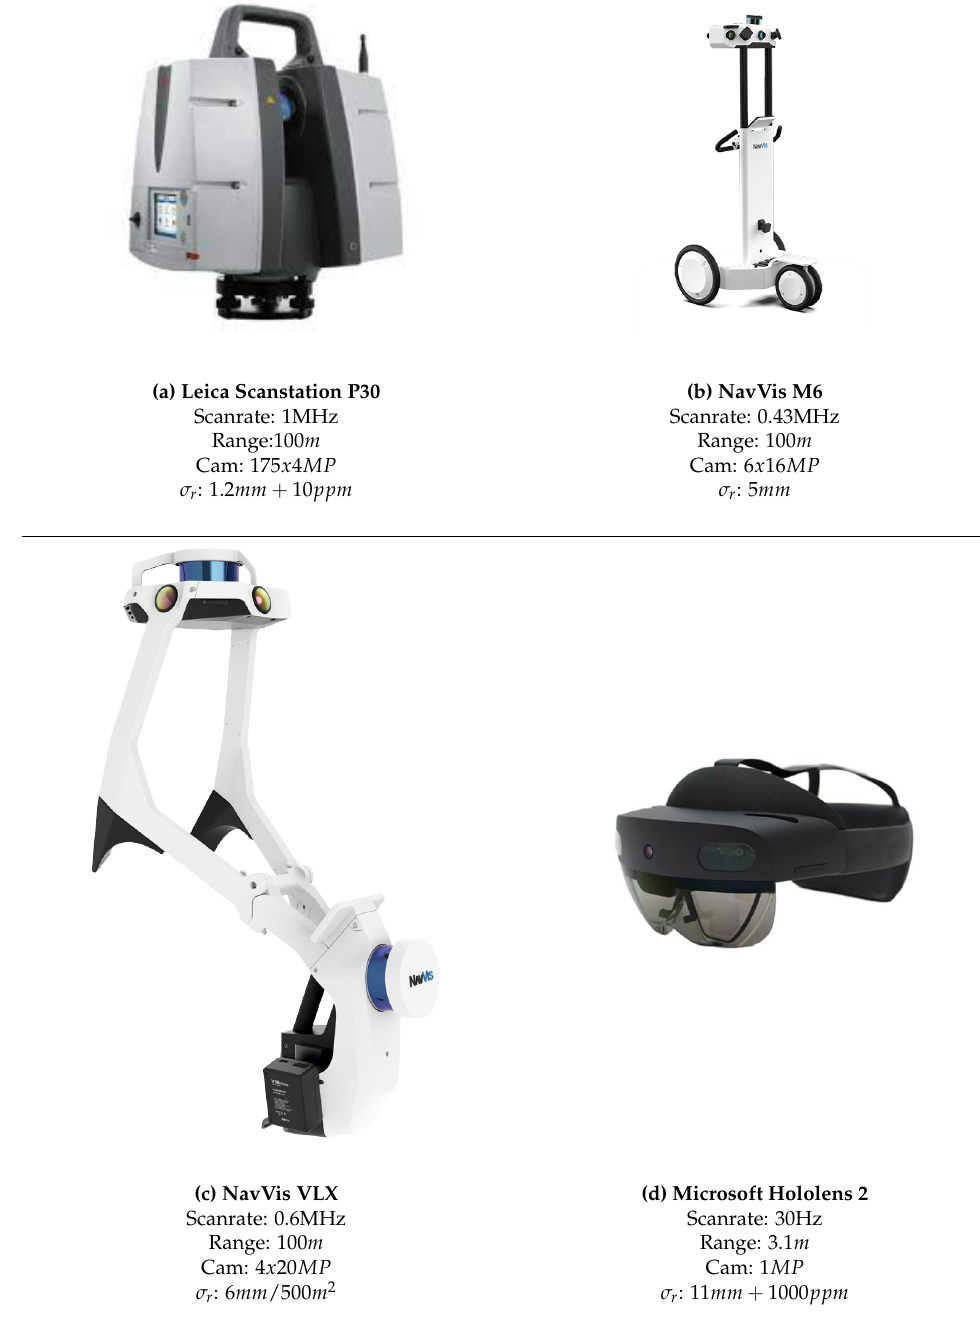
Figure 2. Overview of the theoretical sensor